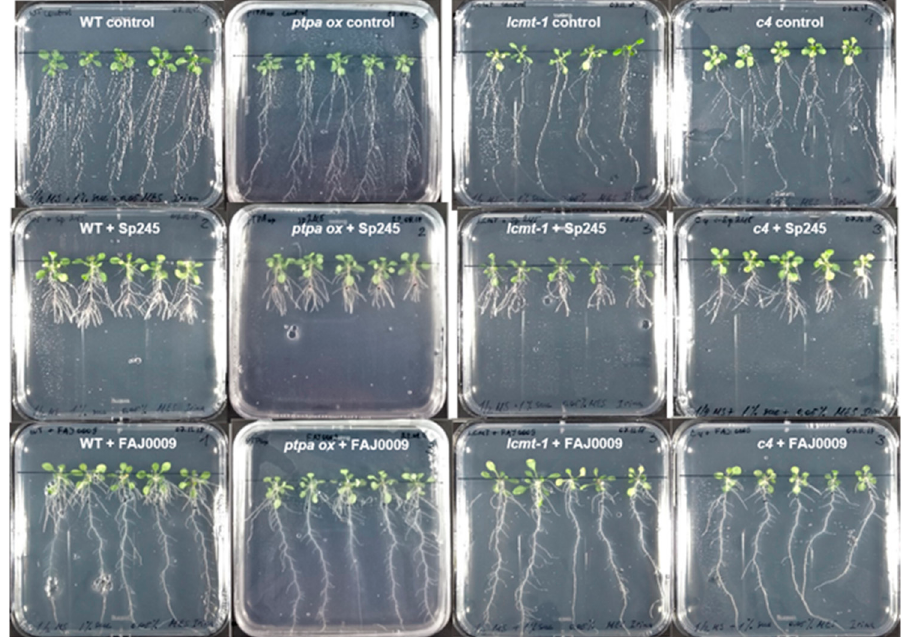
Figure 7. Visual phenotype of Arabidopsis WT and mutants treated with A. brasilense . Seedlings of Arabidopsis WT and mutants ptpa ox , lcmt1 , c4 were cultivated without bacteria (upper row) and with A. brasilense Sp245 (middle row) and A. brasilense FAJ0009 (lower row) for two weeks.